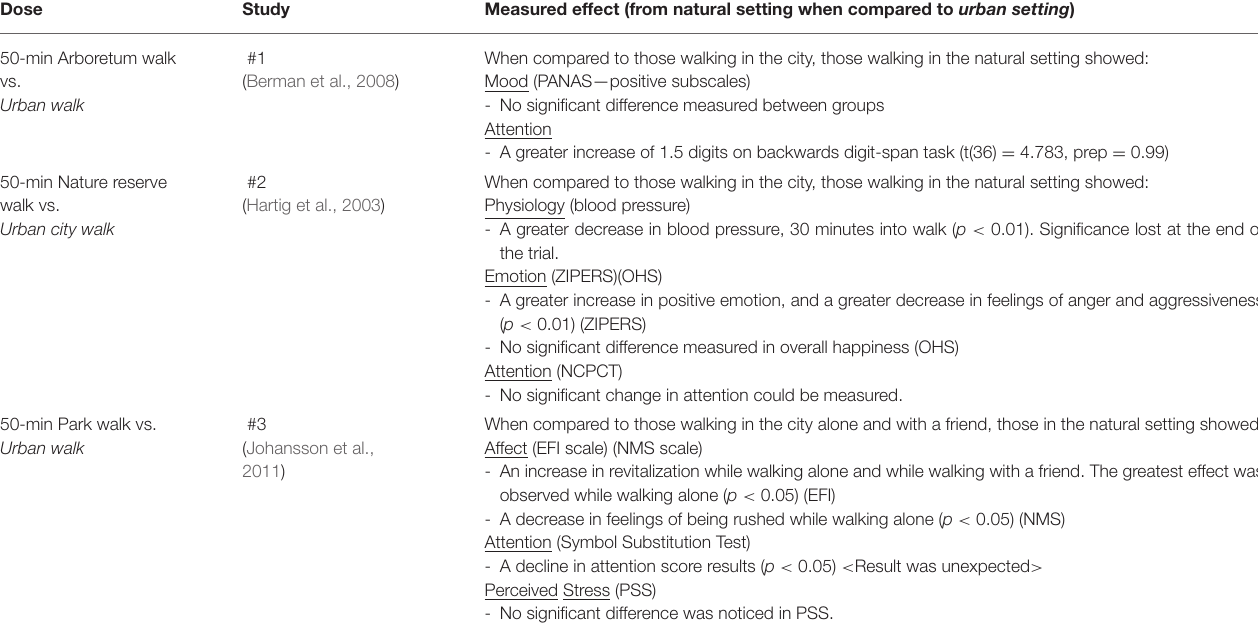
TABLE 5 | Measured effects of time in nature via included studies 31–60min of walking outdoors: natural vs. urban setting. Dose Study Measured effect (from natural setting when compared to urban setting ) 50-min Arboretum walk vs.